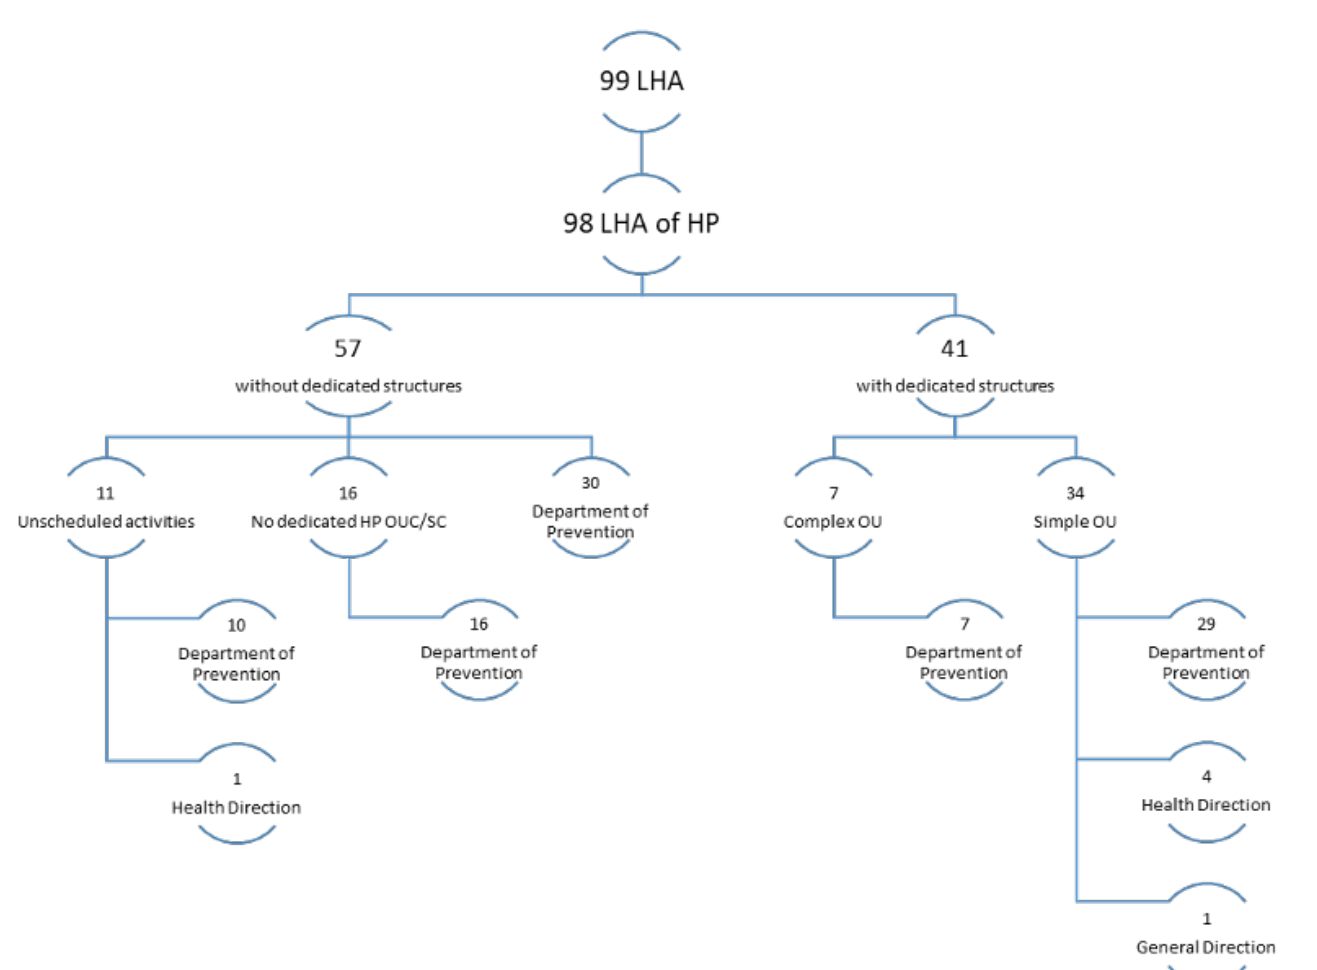
Figure 2. Diagram of hierarchies in Italian LHAs for health promotion.